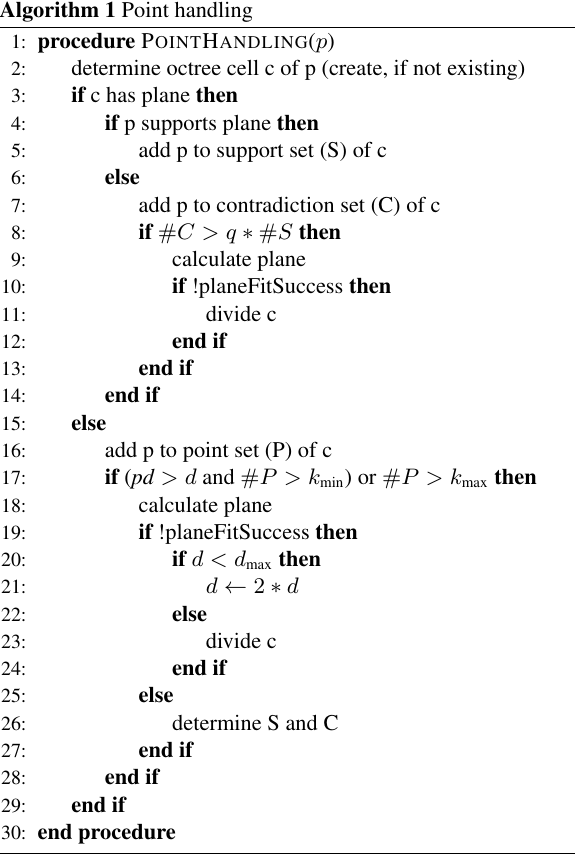
Algorithm 1 Point